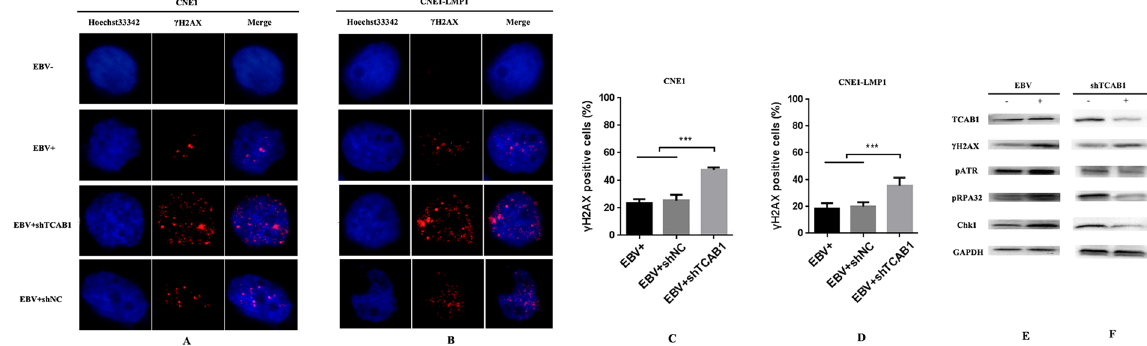
Figure 6. Depletion of TCAB1 inhibits phosphorylation of ATR and its respective downstream target Chk1, resulting in DNA damage accumulation following EBV infection. ( A , B ) CNE1 and CNE1-LMP1 cells were treated with EBV, and some cells were further infected by shTCAB1 and shNC lentivirus for 24 h, followed by immunostaining for γ H2AX. ( C , D ) Quantification of the results in ( A , B ) showing the percentage of nuclei containing > 10 γ H2AX foci among the 200 cells counted for each experiment. The statistical analysis was performed using Student’s t test ( *** P < 0.001). ( E ) CNE1 infected with EBV was subjected to western blotting using different antibodies. ( F ) After exposure to EBV, depletion of TCAB1 interrupted ATR-to-Chk1 signalling in CNE1